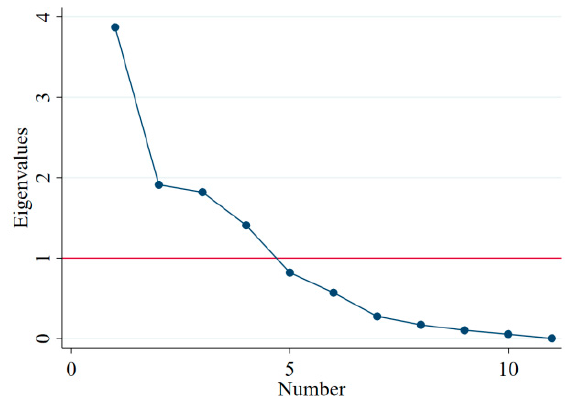
Figure 2. Scree Figure 2. Scree plot.